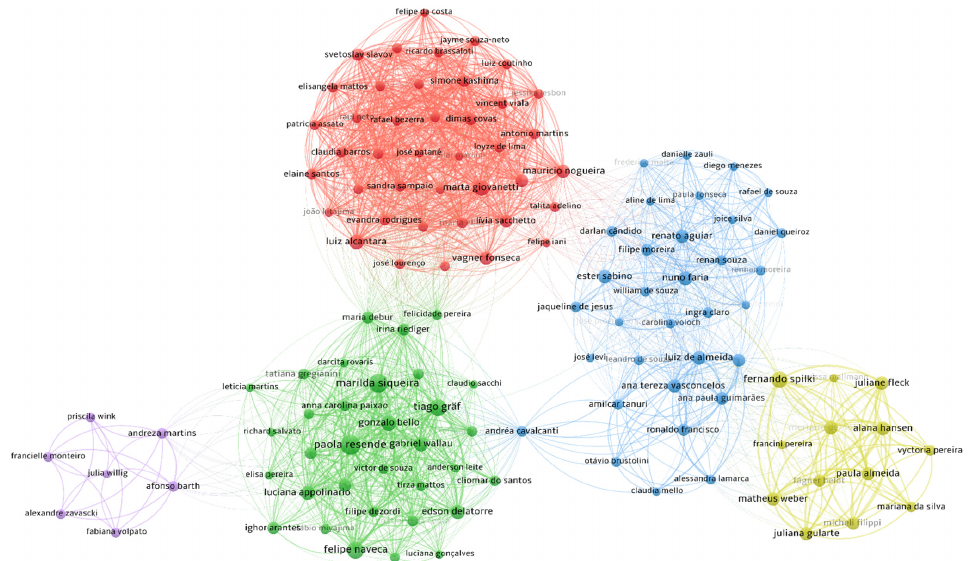
Figure 4. Author co-authorship map. Authors with at least four articles were included ( n = 127 out of 1190). Connectors indicate co-authorships. Circle sizes were weighted by the number of publications included in the systematic review. Five clusters were found, and are characterised by different colours. Metadata is available in Table S6.